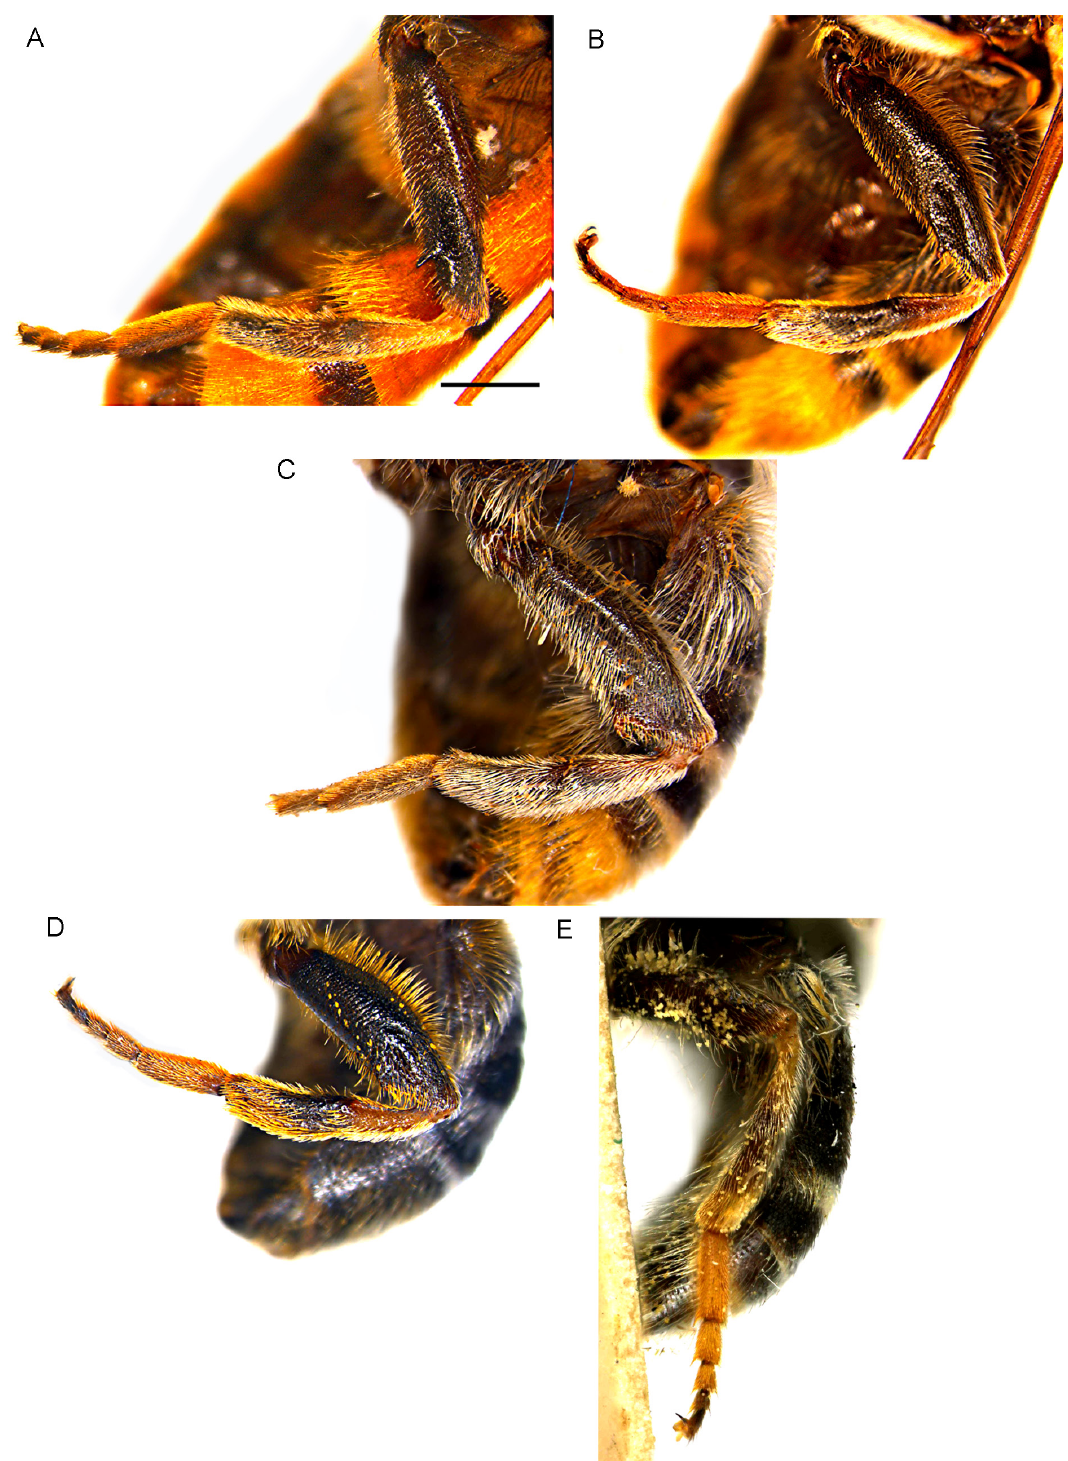
Fig. 16. Female metaleg, lateral view. A . Merodon bombiformis Hull, 1944 (NMSA; FSUNS ID 04278). B . M. multifasciatus Curran, 1939 (FSUNS; FSUNS ID ZA5_243). C . M. zebra Vujić & Radenković sp. nov., paratype (NHMW; FSUNS ID 05725). D . M. lotus Vujić & Radenković sp. nov., paratype (NMSA; FSUNS ID ZA6_067). E . M. nasicus Bezzi, 1915, lectotype (BMNH NHMUK010369943). Scale bar = 2